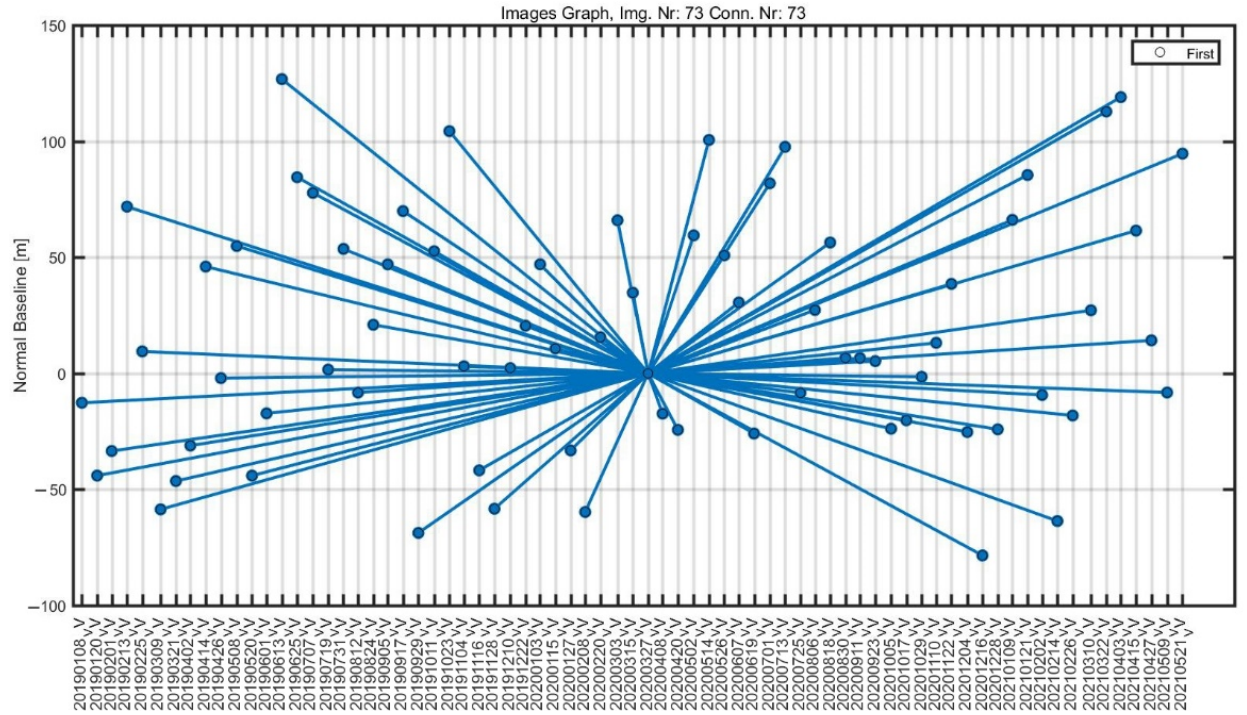
Figure 5. Star graphs showing the descending dataset’s temporal baseline distribution (path number 107).